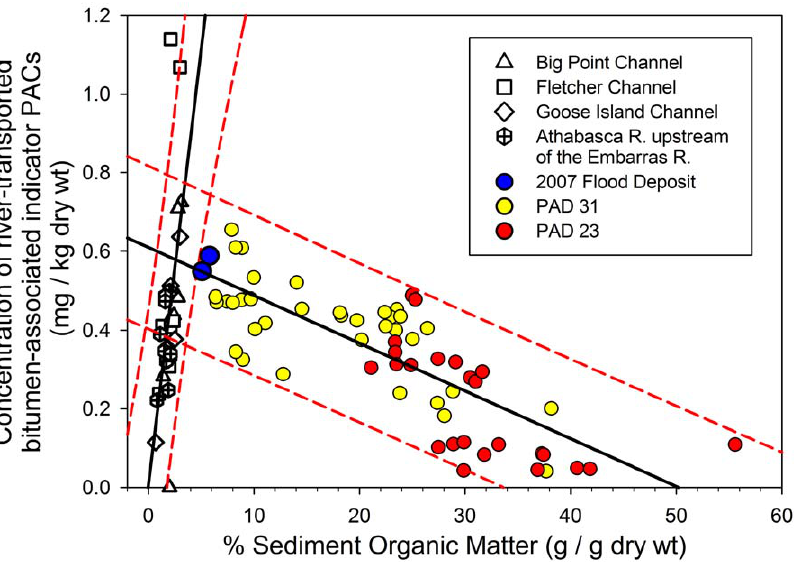
Figure 6. Relations between polycyclic aromatic compound concentration and organic matter content in river versus lake sediment. Scatterplot showing the relations between organic matter (as a percentage of dry sediment mass) and concentration of river-transported bitumen-associated indicator PACs in sediments of lakes PAD 23 (red circles) and PAD 31 (yellow circles) in the Athabasca Delta (data from this study), in bottom sediments of the Athabasca River and its distributaries at four stations within the Athabasca Delta (open symbols; data from [56]), and in sediments deposited on land between Mamawi Creek and PAD 31 by an ice-jam flood in spring of 2007 (blue circles; data from this study). Data include the sum of the concentration of six of the seven river-transported bitumen-associated indicator PACs that were common to both the lake sediment data set (this study) and the river bottom sediment from RAMP [56] (note: FLPY-4 was not reported by [56]). The lines of best fit (solid black line) and 95% prediction intervals (dashed red lines) are presented for linear regressions of sediment organic matter content and river-transported bitumen-associated indicator PAC concentrations for both the river bottom sediments and the lake sediments.